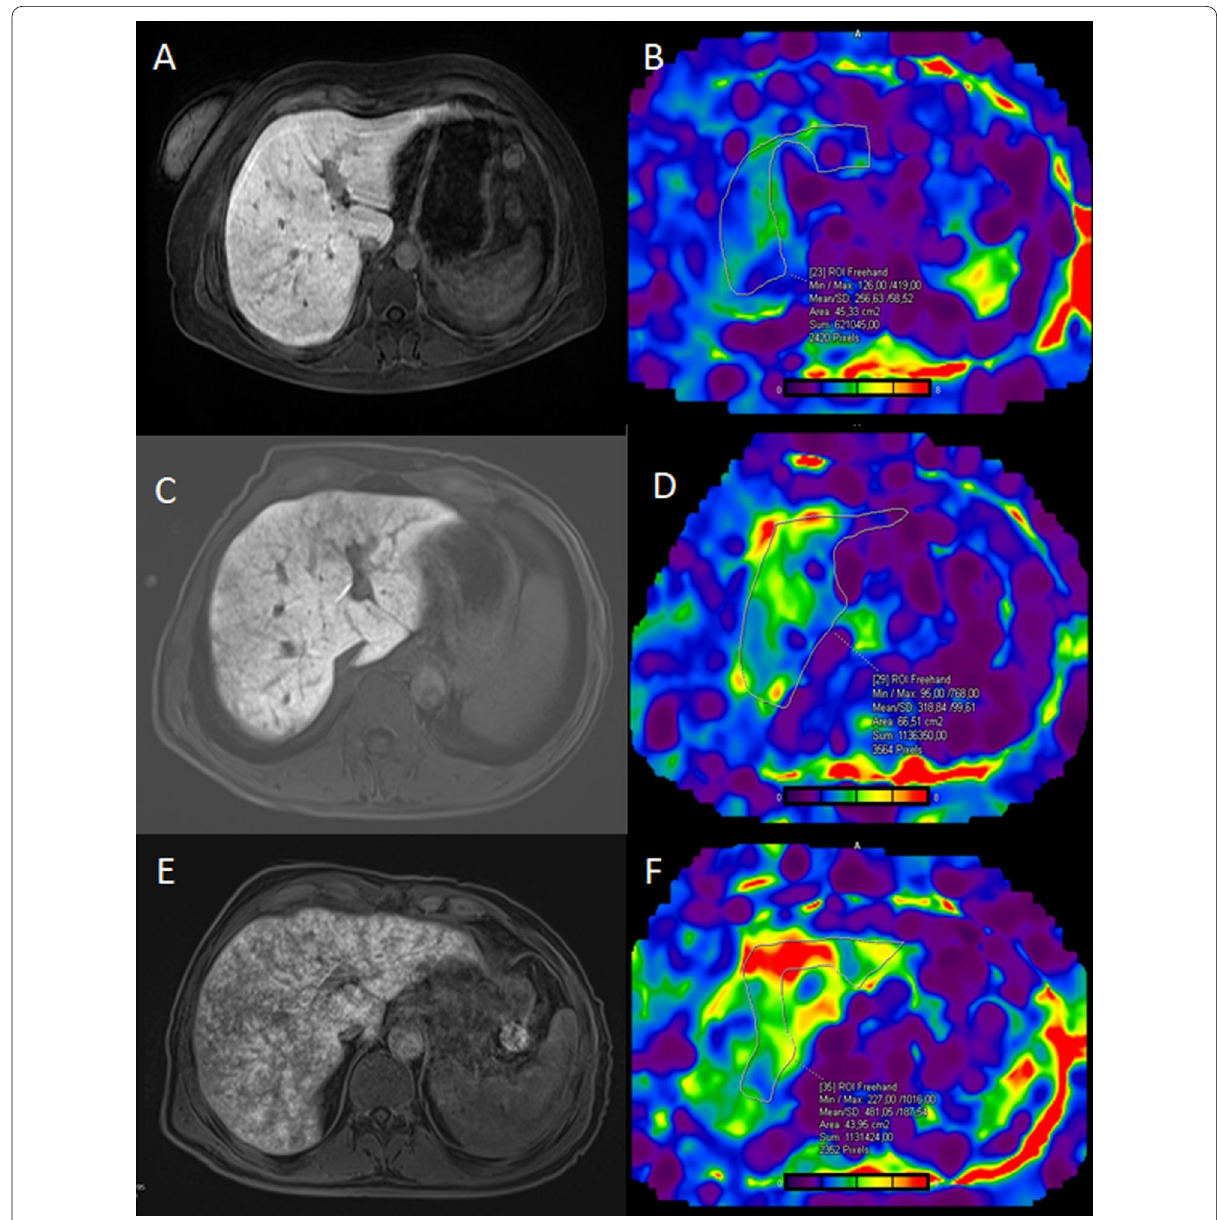
Fig. 7 According to the amount of hypointensities on the hepatobiliary phase; Images of mild ( A ), moderate ( C ), advence ( E ) grade SOS patients. Stiffness maps of the same patients; mild ( B ), moderate ( D ), advence ( F ). As the degree of SOS increases, liver stiffness also increases. Parenchymal stiffness was measured as 2.56 kPa ( B ) in the “mild” case, 3.18 kPa ( D ) in the “moderate” case, and 4.81 kPa ( F ) in the “advance”